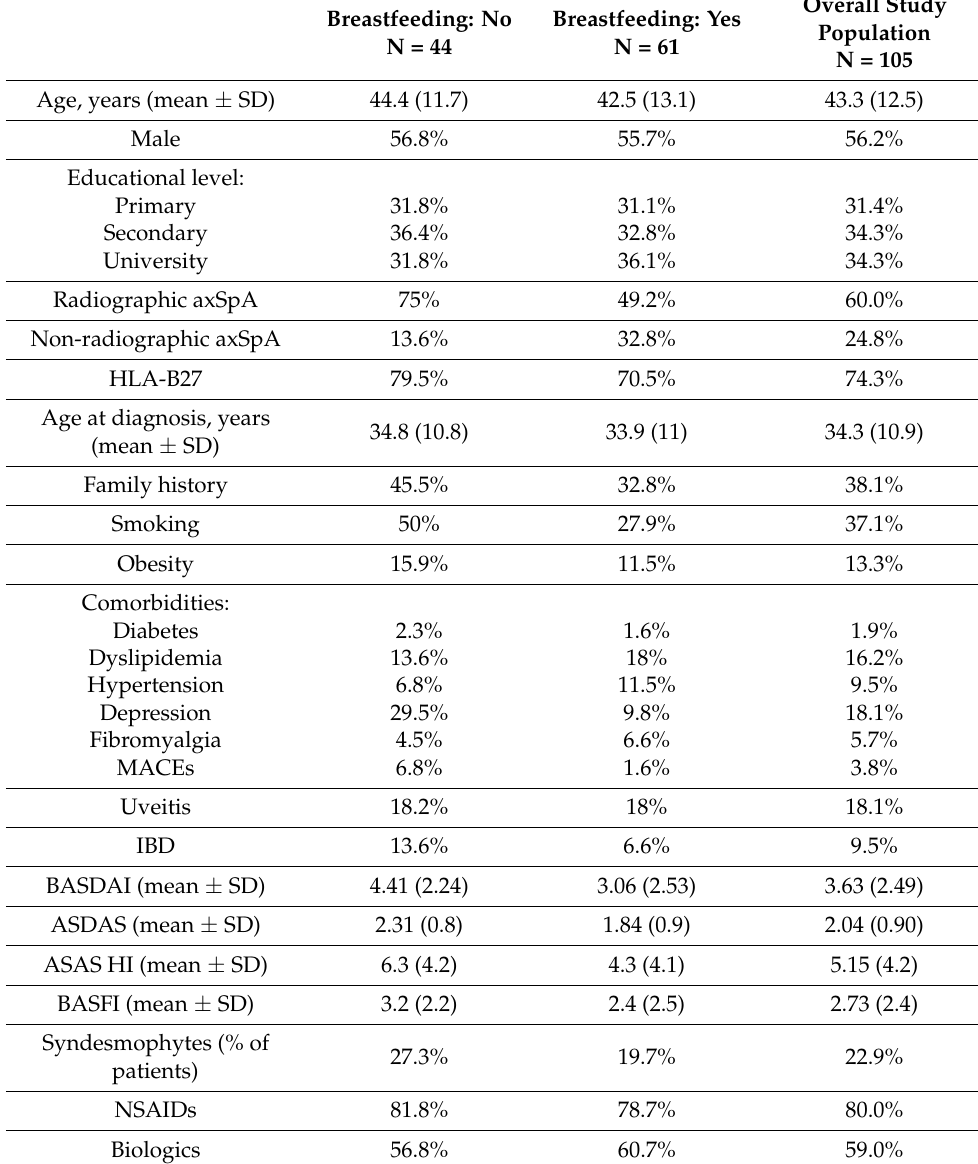
Table 1. Main characteristics of the disease in the overall study population and according to the history of breastfeeding.